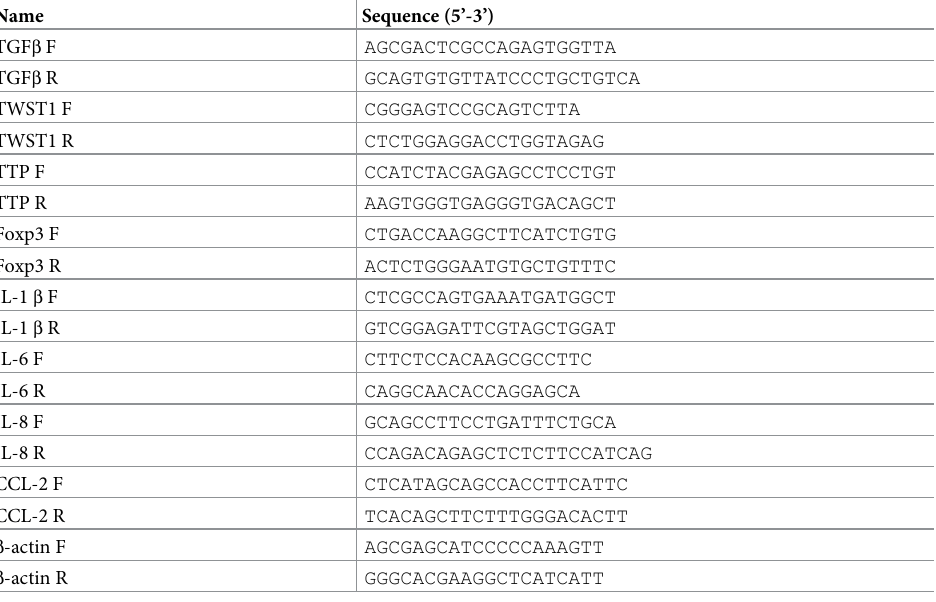
Table 1. Sequence of primers used for